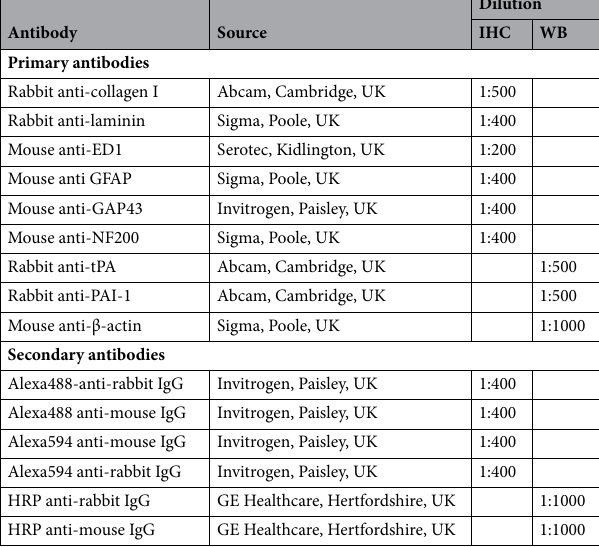
Table 1. List of primary and secondary antibodies used in this study. IHC immunohistochemistry, WB western